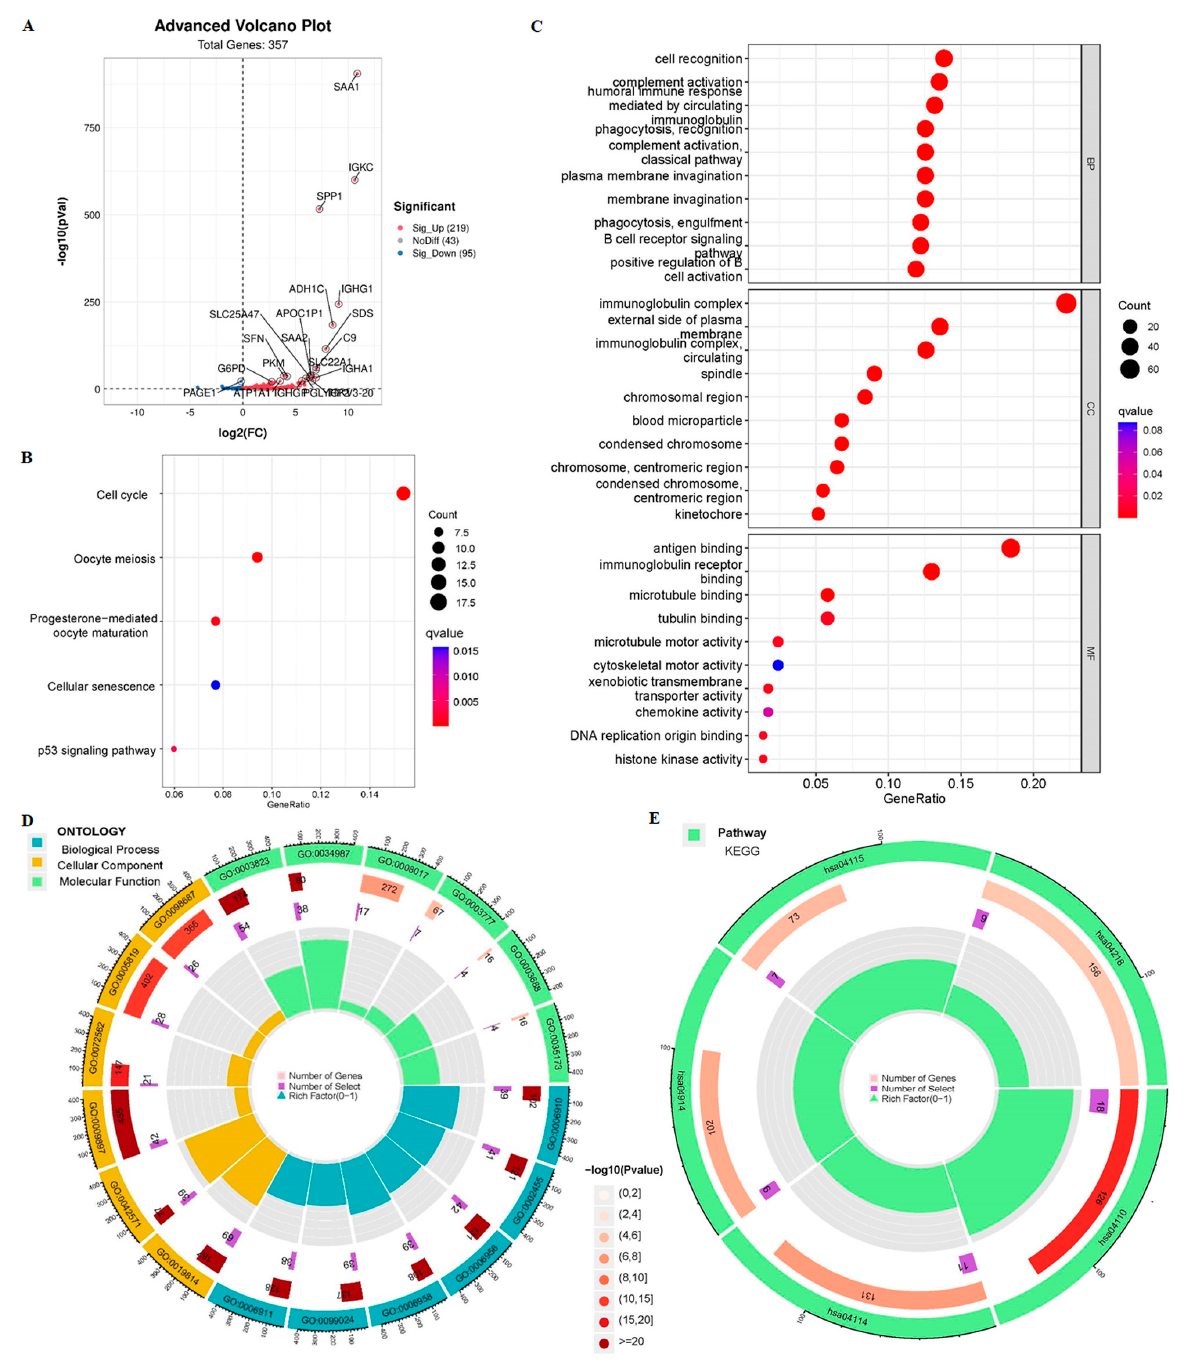
Figure 6. The GO biofunction and KEGG pathway enrichment analysis of two risk groups based on the 9-crLncRNA. ( A ) The volcano map reflects the 357 differentially expressed genes between two risk groups (log2|FC| > 1, p < 0.05). Green, red, and gray represent downregulated, upregulated, and no difference genes, respectively. Bubble graphs for KEGG pathways ( B ) and GO enrichment ( C ) Circle diagrams of significant GO functional items ( D ) and significant KEGG pathways ( E ). The latter contains the name of the dataset, the number of genes in the dataset, and the proportion of crLncRNAs in the pathway. The outer ring is the name of the dataset, the inner circles are the number of genes in the dataset and the proportion of crLncRNAs in the pathway. p < 0.05 was considered statistically significant.